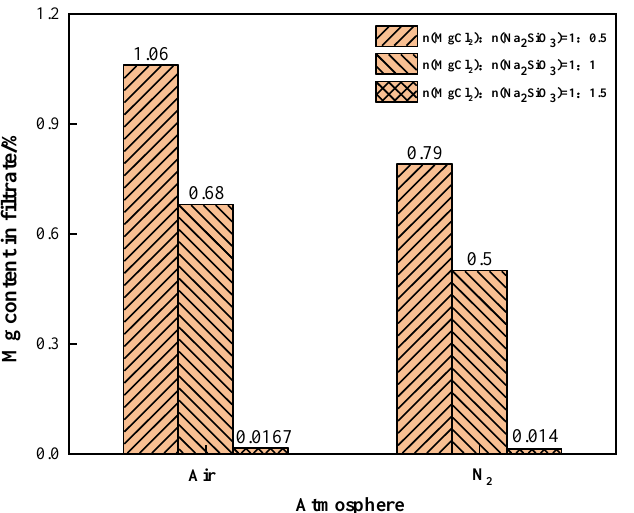
Figure 16. The effect of phase transition atmosphere on the change of Mg content in the filtrate. The Mg removal rate increased with the increase of additive dosage when filtering under air or N 2 conditions, as shown in Figure 17. When the additive dosage MgCl 2 :Na 2 SiO 3 was 1:0.5, the increase in Mg removal rate was more obvious after the phase transition experiment under the N 2 condition. At this time, N 2 should be selected as